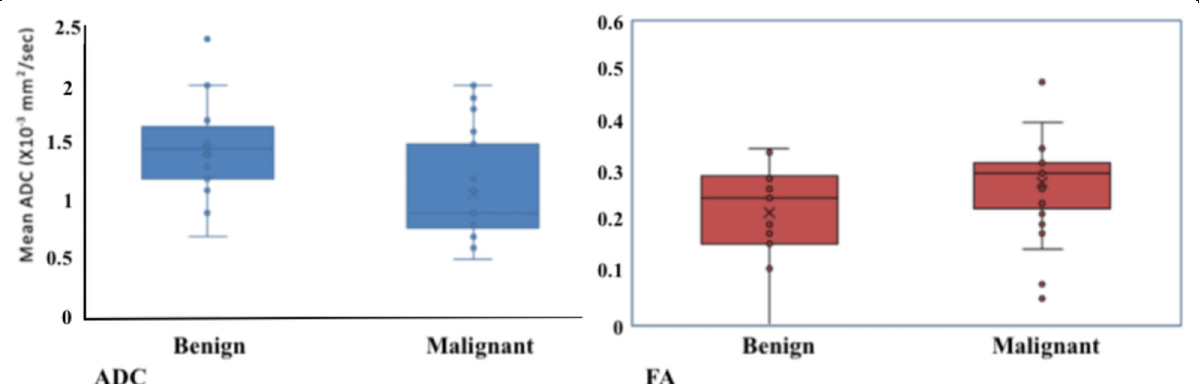
Fig. 1 Boxplot of ADC and FA values according to lesion ’ s pathology (benign and malignant lesions)